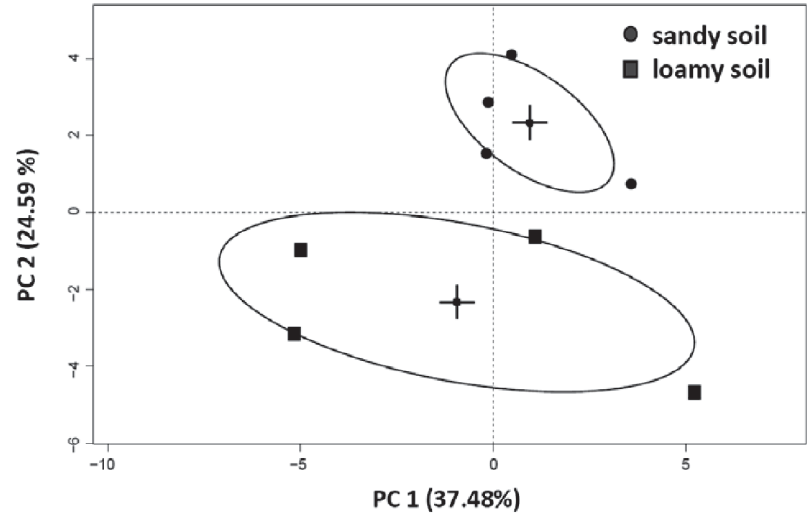
Figure 3. Principal components (PC 1 and PC 2) of the microbial communities cultivated in two different soil types either conditioned by the growth of three species or unconditioned, with 95% CI. Percent of explained variance is in parentheses. The optimal AWCD chosen for analysis was